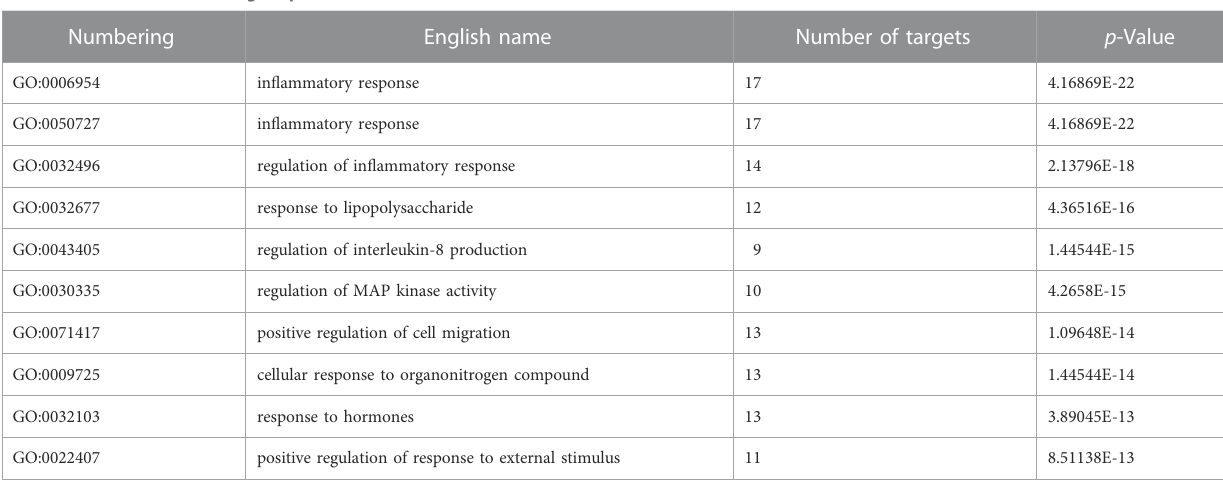
TABLE 5 Results from GO biological